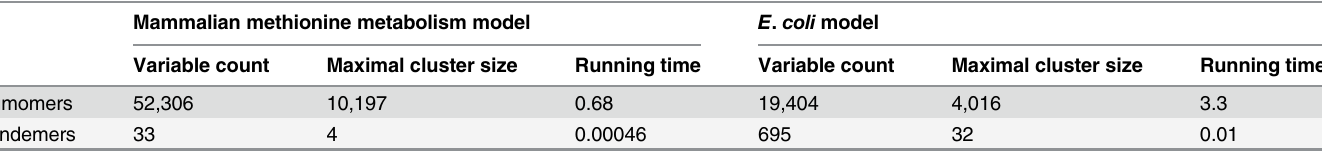
Table 2. Comparison of the performance of the cumomers and tandemers methods in calculating tandemer distributions on mammalian methio- nine and E . coli networks. Mammalian methionine metabolism